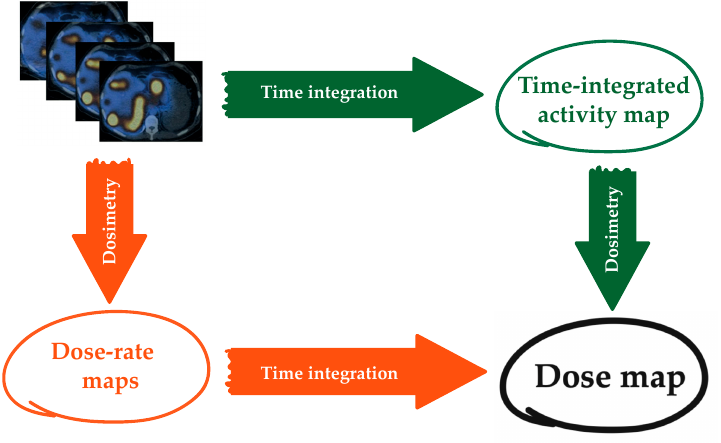
Figure 4. Concept map of the two possible approaches to calculate an absorbed dose map.